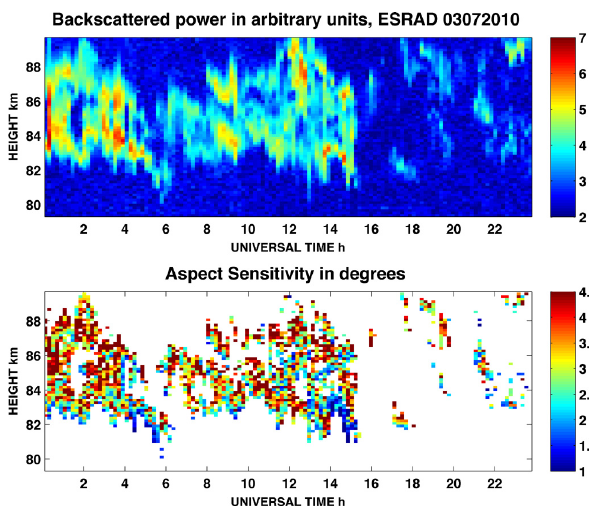
Fig. 2. Backscattered power (the upper panel) and aspect sensitivity (the lower panel) measured with ESRAD MST radar on 3 July